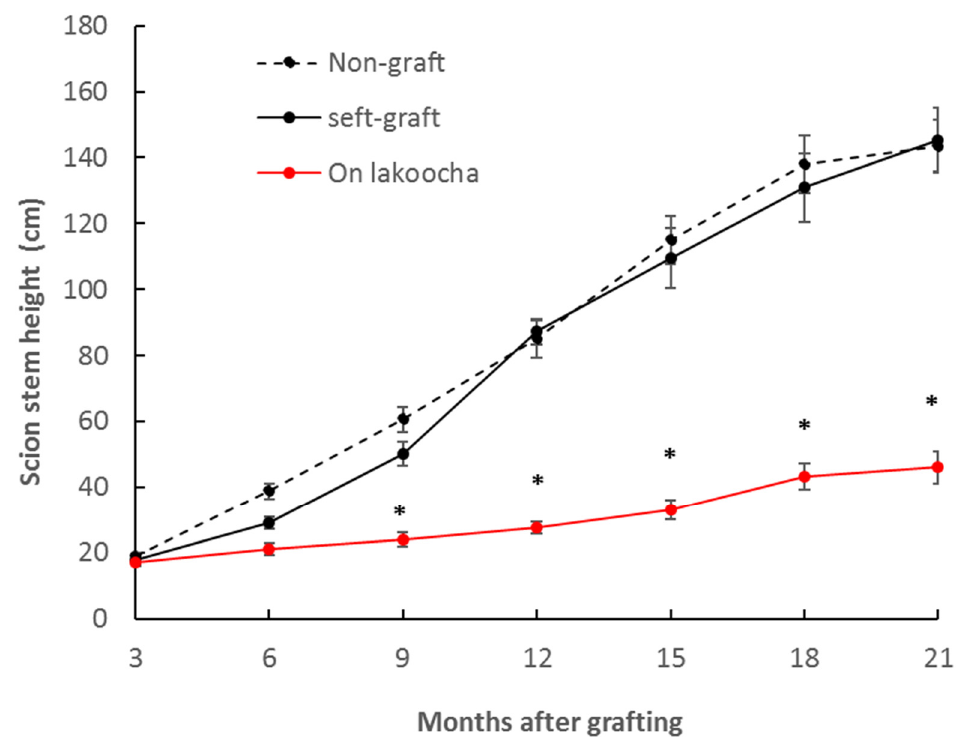
Figure 2. Growth curve comparison of breadfruit plants on different rootstocks. All values represent mean ± SE from five biological replicates. * Significant difference ( p < 0.05).